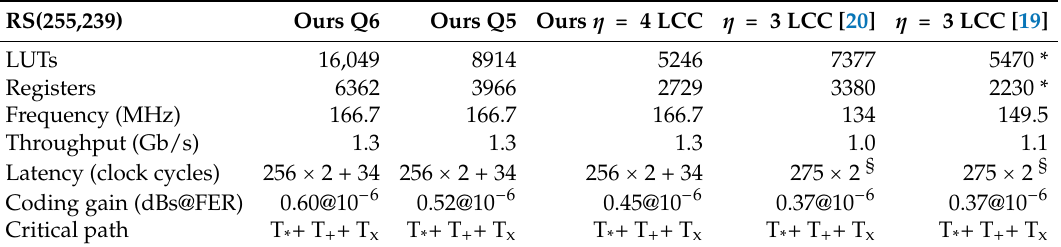
Table 3. Implementation results of RS decoders in a Virtex-V XC5vlx50t-3 FPGA device.